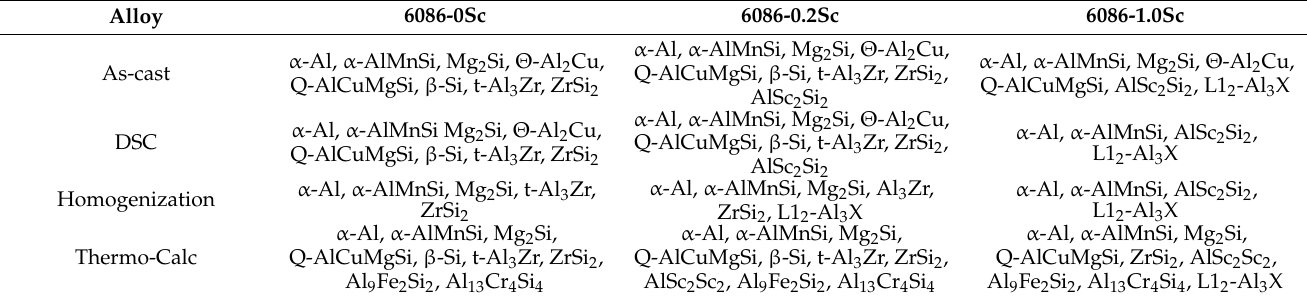
Figure 5. 2D-XRD images of the investigated alloys. ( a – c ) as-cast condition, ( d – f ) after DSC, ( g – i ) after homogenization. Table 3. Phases identified in different conditions of the investigated alloys using XRD and EDS in SEM and TEM.